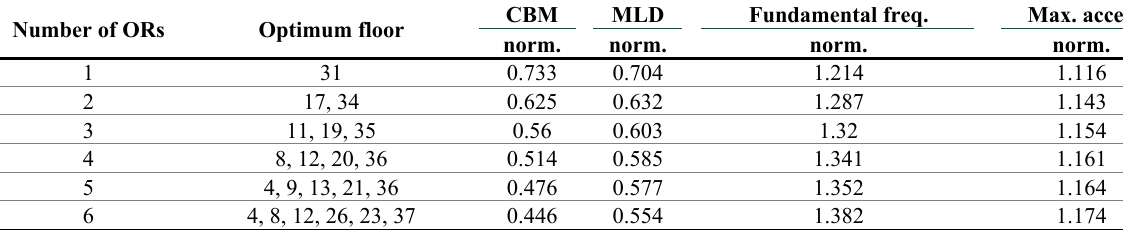
Table 4. Results of single-objective optimizations for CBM (OR-BT) Number of ORs-BTs Optimum floor